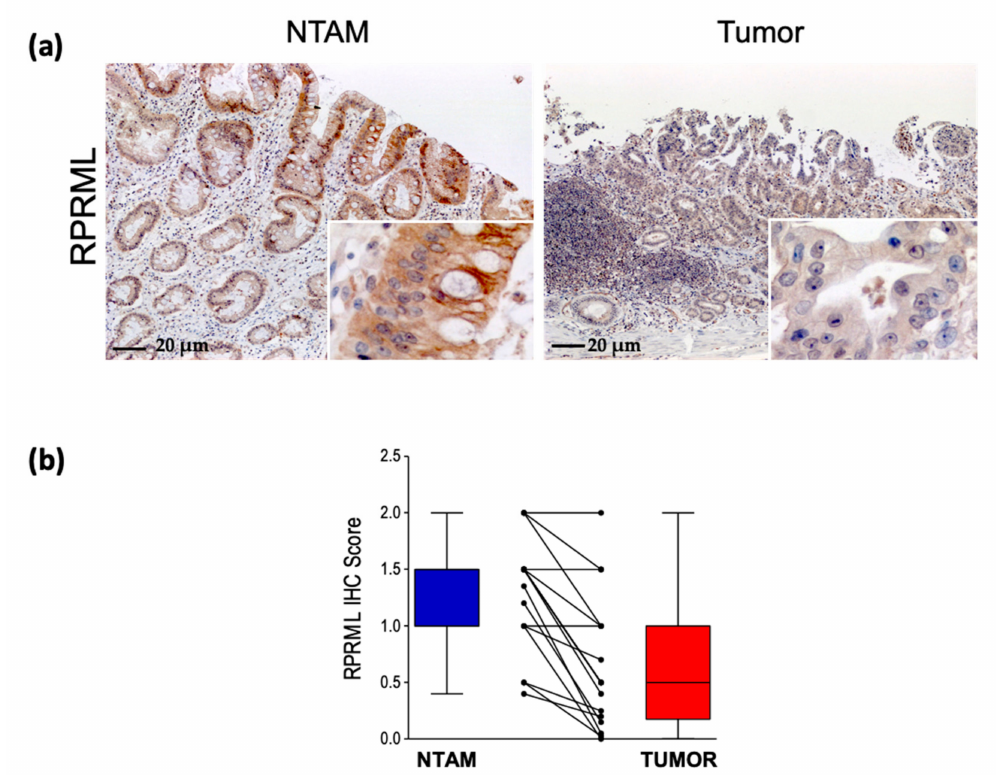
Figure 1. Reprimo-like (RPRML) expression is downregulated in gastric cancer (GC). ( a ) Representative images of RPRML immunohistochemical (IHC) staining assay in tumor and non-tumor adjacent mucosa (NTAM) samples from GC patients. Magnification: main image, × 100; insets, × 400. Scale bar = 20 µ m. ( b ) Di ff erential RPRML protein expression in 17 matched pairs of tumor and NTAM samples from GC patients. Box plots (median ± interquartile range (IQR)) and aligned dot plots of RPRML IHC scores are shown. Statistical analysis: Wilcoxon matched pairs signed rank test ( p = 0.001).